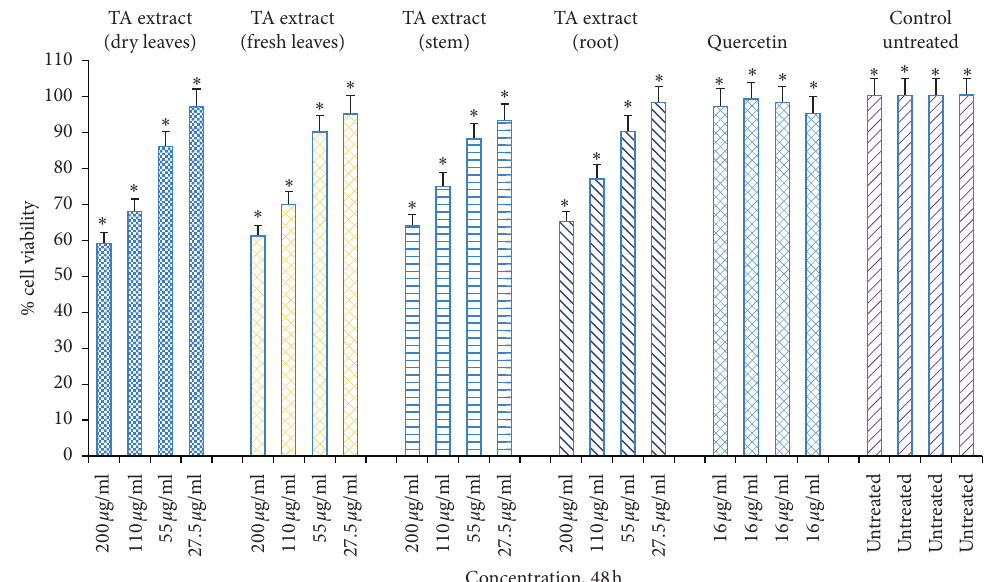
Figure 4: Cell viability determined by MTT assay. Hs27 skin fibroblasts were seeded at a density of 10,000 cells/well in 96-well plates and allowed to incubate overnight to attach to the surface. Next day, treat the cells with TA extracts (fresh and dry leaf, stem, and root extracts) for 48h along with quercetin as a positive control (16 μ g/mL) and control as untreated. Data shown as mean ± SEM; n � 3 and ∗ p < 0 . 05.